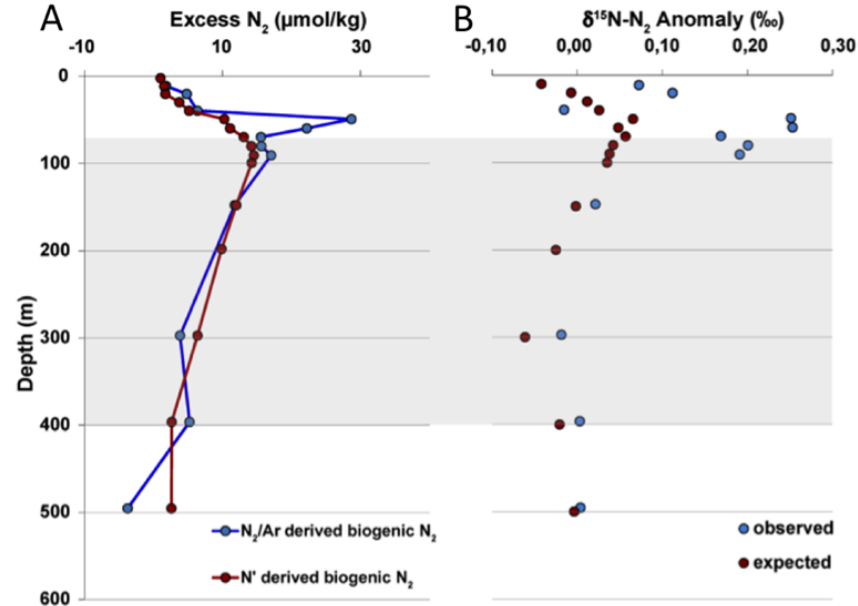
Fig. 4. Biogenic N 2 depth profiles at Station 7. (A) Measured and expected excess N 2 (biogenic) concentration (µmolkg − 1 ). (B) The mea- sured and expected δ 15 N anomaly for N 2 . OMZ indicated as a shaded depth interval. Expected biogenic N 2 is derived from the nitrogen anomaly (N 0 ) assuming Richards stoichiometry (Richards, 1965) after taking into account N 0 for water masses upstream of the OMZ (Ap- pendix A). Measured biogenic N 2 is calculated from deviations in N 2 /Ar ratio from values expected at saturation with the atmosphere at in situ temperature and salinity and adjusted for physical sources of N 2 /Ar anomaly by comparison with stations outside the OMZ (Chang et al., 2010). The expected δ 15 N anomaly for N 2 is based on isotopic mass balance between the system’s source NO − NO − (Appendix 2